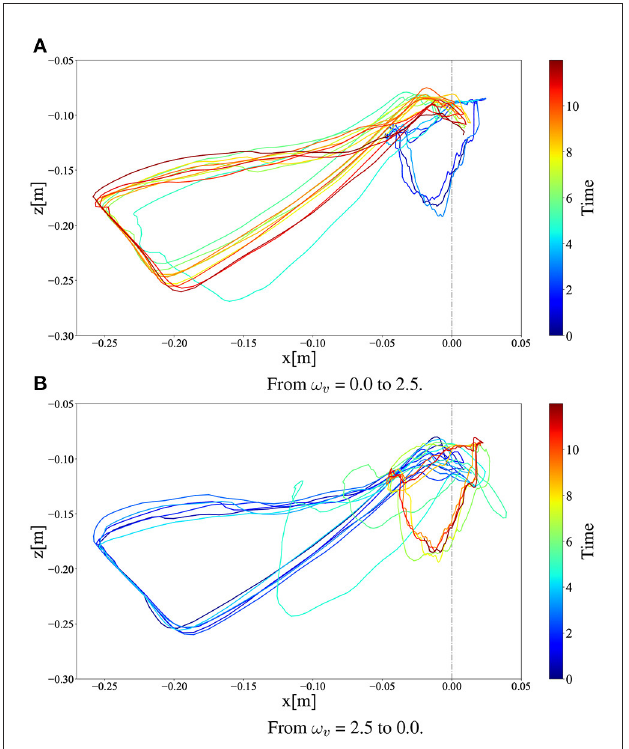
FIGURE11 x – z CoM trajectories of the right thigh segment in (A) walk-to-run transition and (B) run-to-walk transition for 12 s (before and after the ω v change). In the figures, we linearly changed ω v at 4 s.